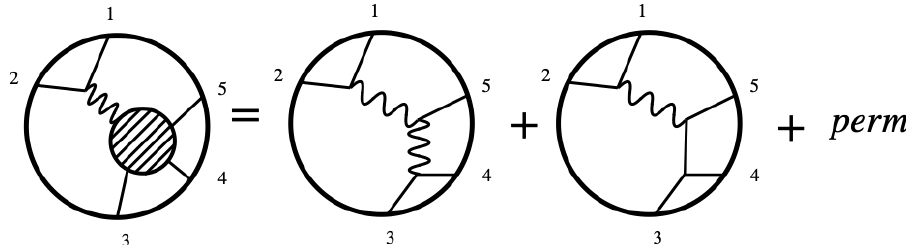
Figure 6. Factorization on an internal graviphoton line. Here \ perms " denotes the other inequiv- alent diagrams obtained by permuting the external legs 3, 4 and 5. Upon factorizing the (cid:12)ve-point function on the internal graviphotonline, we obtain a three-point function hO 20 0 O 20 0 J (cid:22) i and a four-point function hJ (cid:22) O 20 0 O 20 0 O 20 0 i